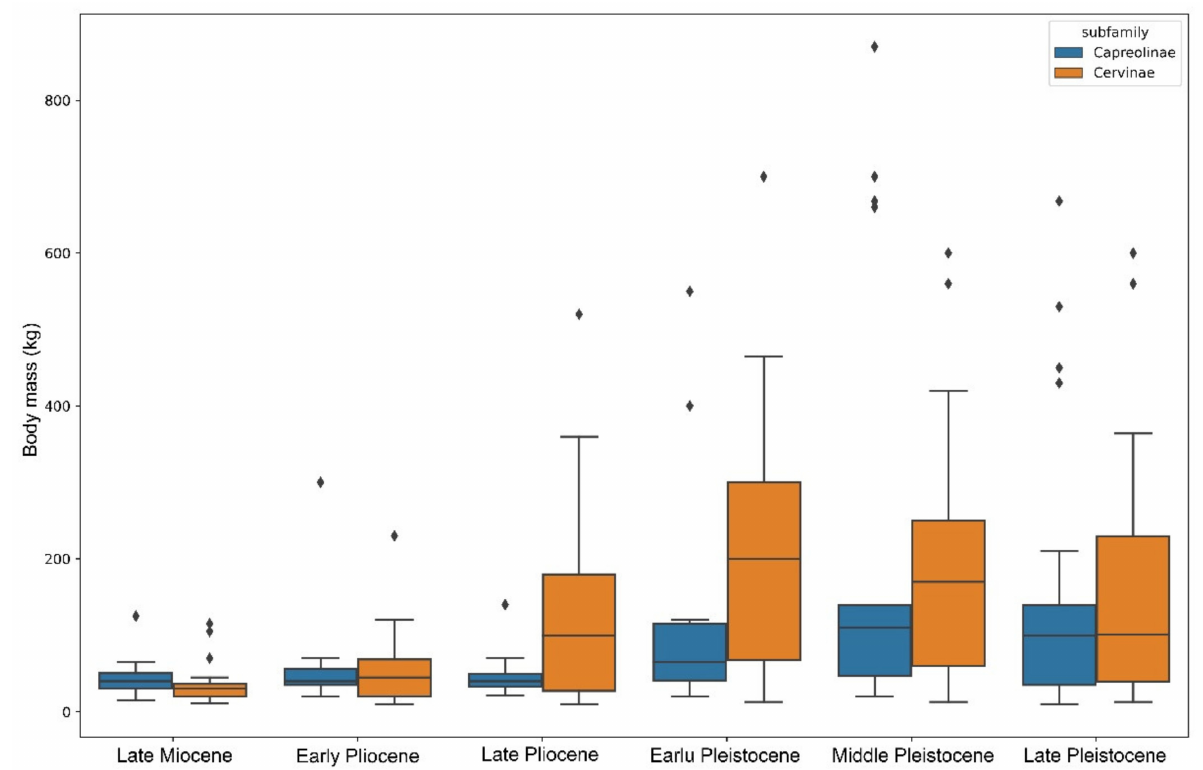
Figure 6. Range of deer species body masses from the late Miocene to the late Pleistocene from all zoogeographic realms. Outliers (exceptionally large species) are represented by black